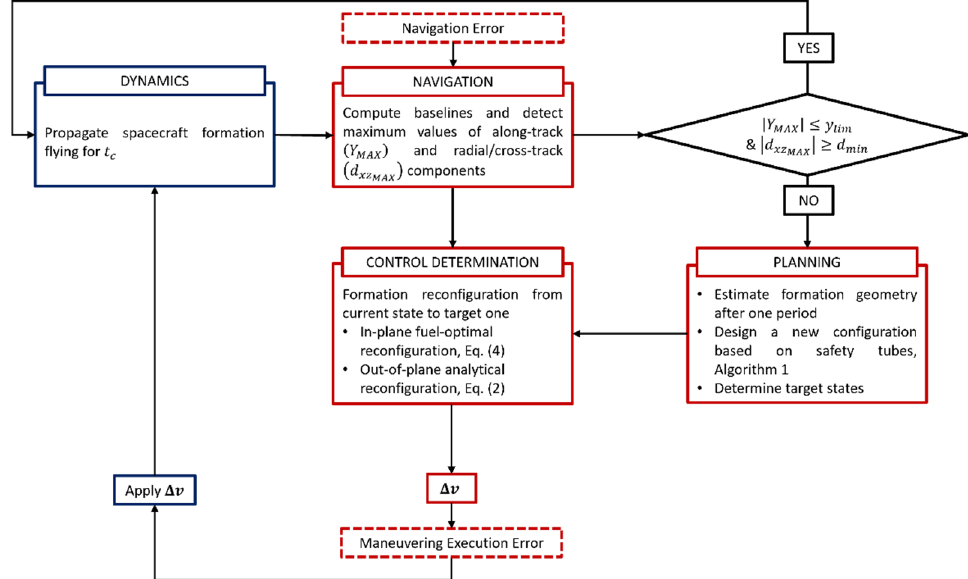
Figure 5. Architecture of the simulation environment realized through GMAT (blue boxes) and MATLAB (red boxes).